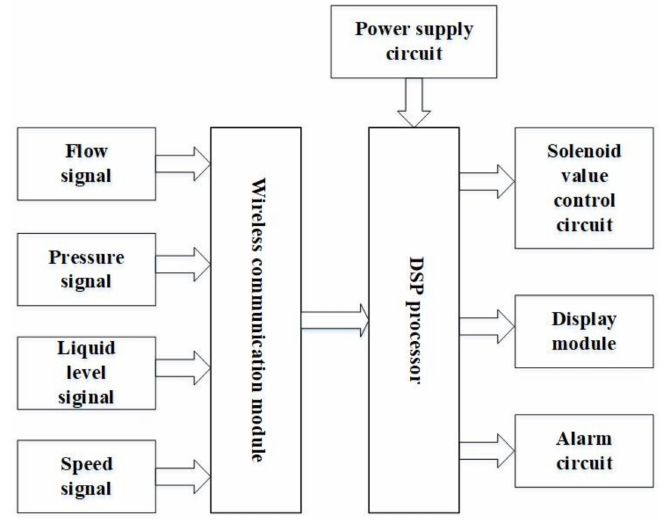
Figure 5. Block diagram of variable-rate herbicide spraying controller implemented in this